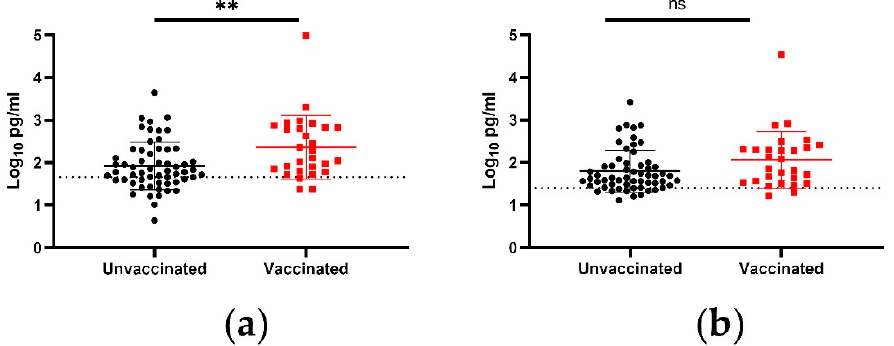
Figure 2. Anti-SARS-CoV-2 IgA in NP swabs from asymptomatic Delta variant SARS-CoV-2 infections. IgA capable of binding ( a ) the SARS-CoV-2 S1 protein or ( b ) the SARS-CoV-2 RBD was measured via flow cytometry. Symbols represent individual subjects, midlines represent the mean, error bars represent the standard deviation, and dashed lines represent the lower limit of the assay. Unvaccinated and vaccinated groups were compared by Mann–Whitney test. ns = p > 0.05, ** = p < 0.01.